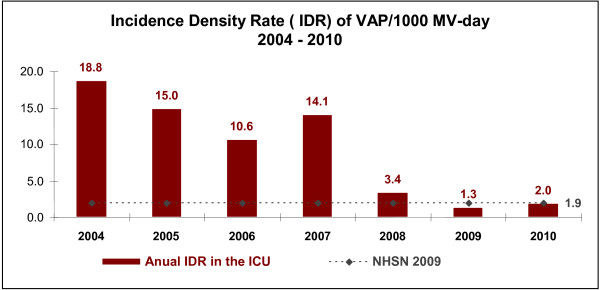
Incidence density rate (IDR)of VAP/1000 ventilator-days from2004 to 2010 inthe ICU.